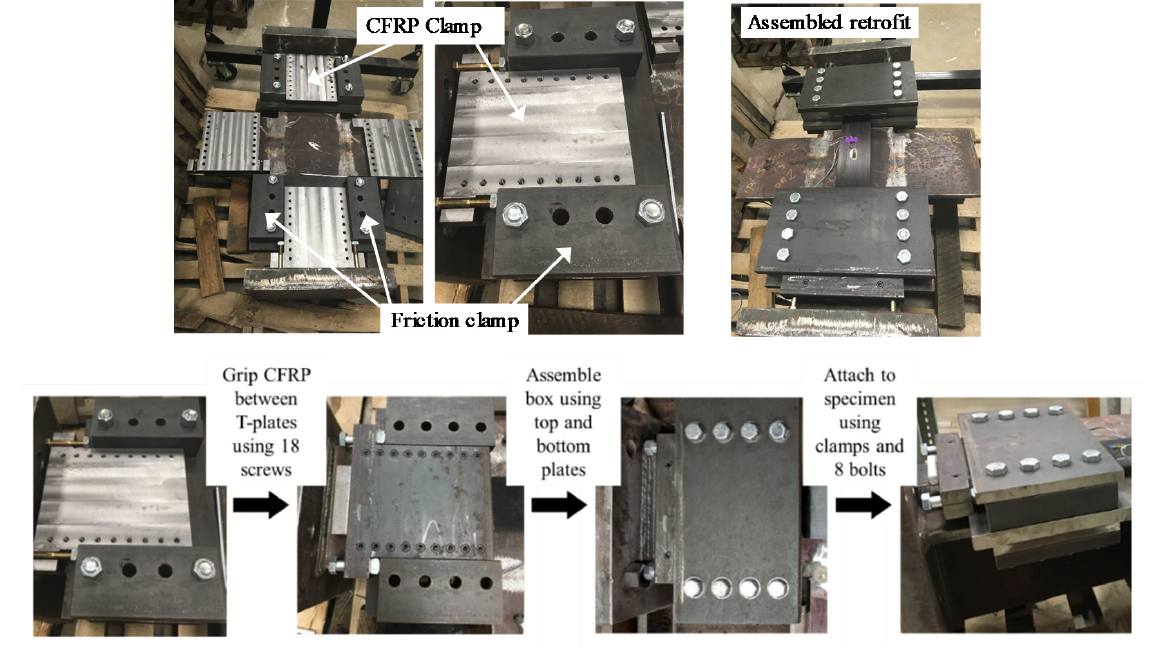
Figure 14. Retrofit components and assembly steps for the CFRP retrofit.